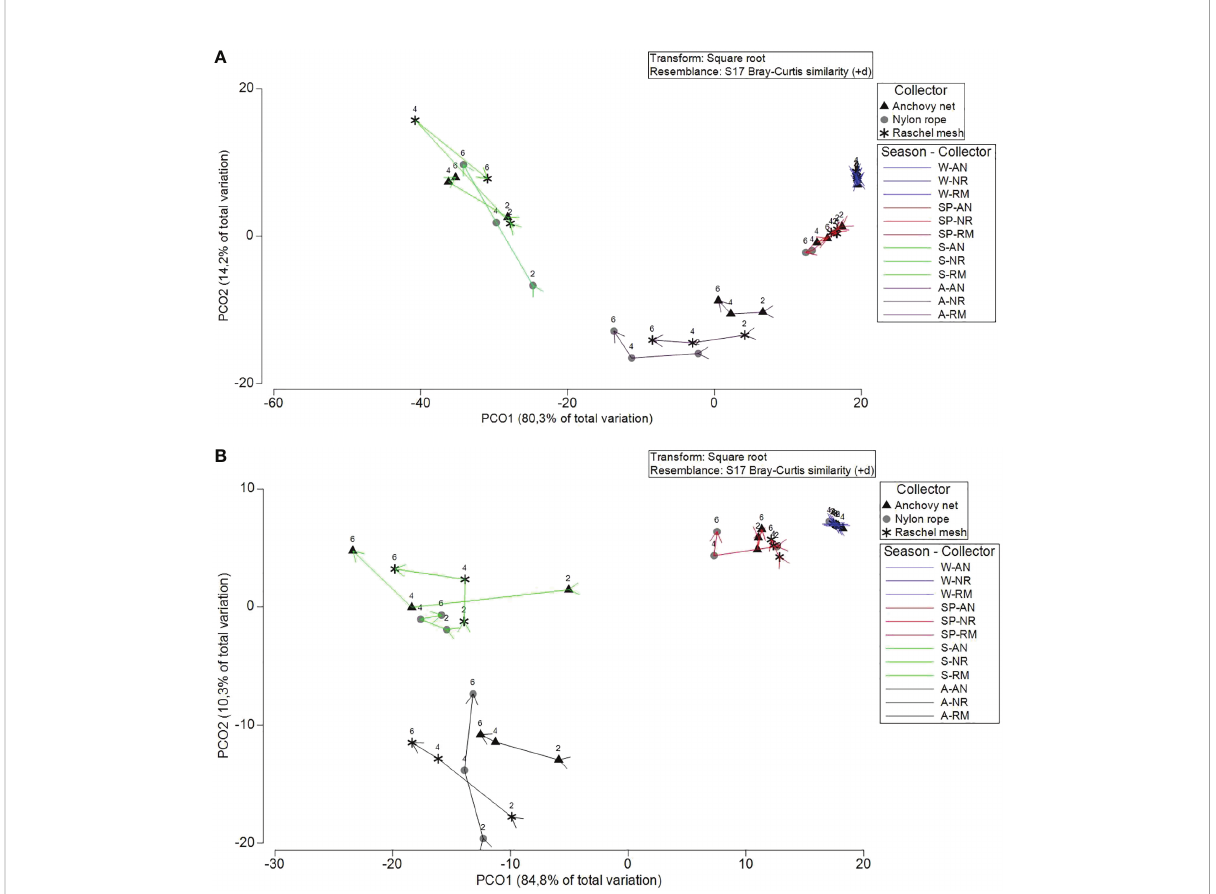
FIGURE 4 Principal coordinates analysis (PCO) from Euclidean distances among centroids per season (winter=W, spring=Sp, summer=S, Autumn=A), collector (anchovy net=AN, nylon rope=NP, raschel mesh = RM), at 2, 4 and 6 m depth for (A) Coliumo Bay and (B) Punta Lober ı ́